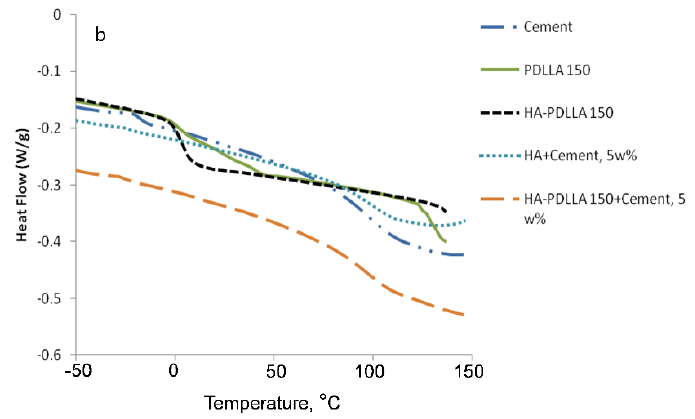
Figure 12. DSC traces of ( a ) poly(lactide) at (M):(C) = 150 (PDLLA 150), hydroxyapatite-polylactide grafts at (M):(C) = 150 (HA-PDLLA 150); ( b ) radiopaque bone cement Simplex P SpeedSet (Cement) and physical mixtures of: hydroxyapatite (5 % weight) + Simplex P SpeedSet (HA + Cement) and HA-PDLLA 150 (5 % weight) + Simplex P SpeedSet (HA-PDLLA 150 + Cement).